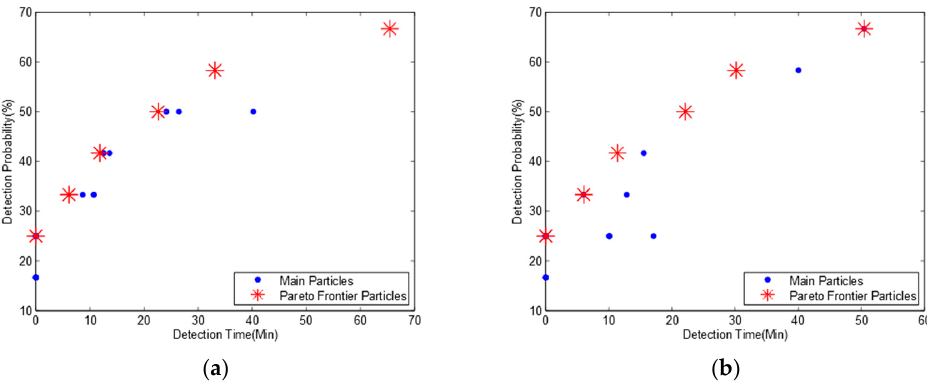
Figure 7. Pareto frontiers for bidirectional water flows with three monitoring nodes and a detection threshold of 0.01 mg/L. ( a ) Probability ratio of river networks A and B is 70:30; ( b ) Probability ratio of river networks A and B is 30:70.